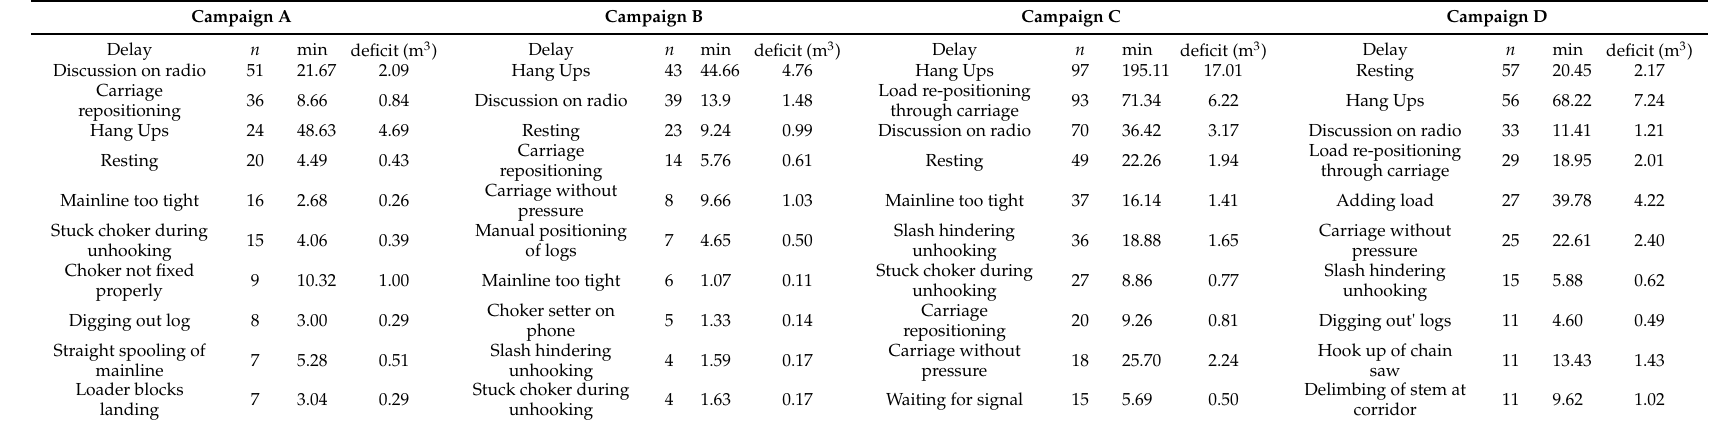
Table A4. Most frequent occurring single delay events during SSH Operation , their total duration and associated cumulative production deficit in m 3 based on unproductive time with reference to PSH 0